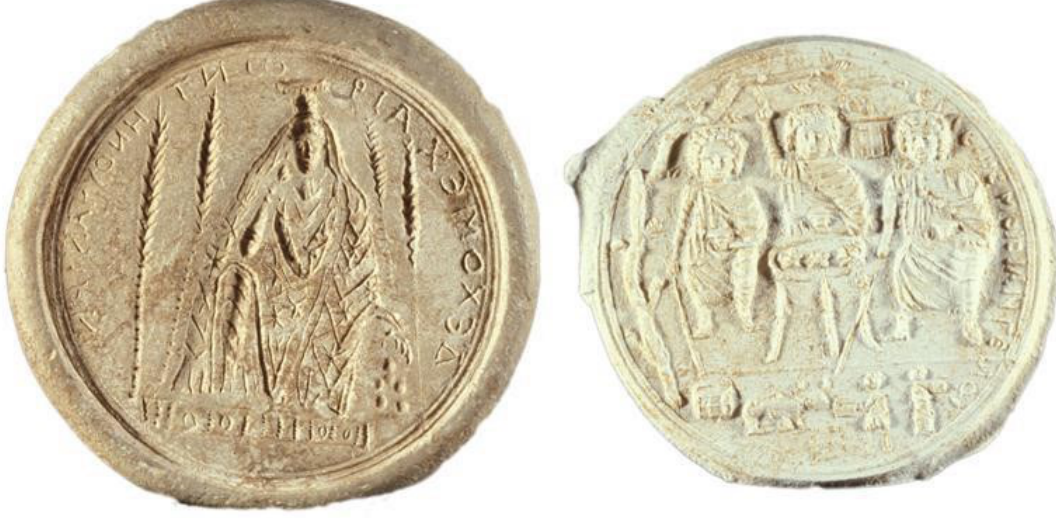
Figure 1 Two-sided mould, fourth to fifth century, limestone, 13.8 cm diameter. Malcove Col- lection M82.271, Gift of Dr. Lillian Malcove, 1981. Courtesy Art Museum University of Toronto. Photo: Toni